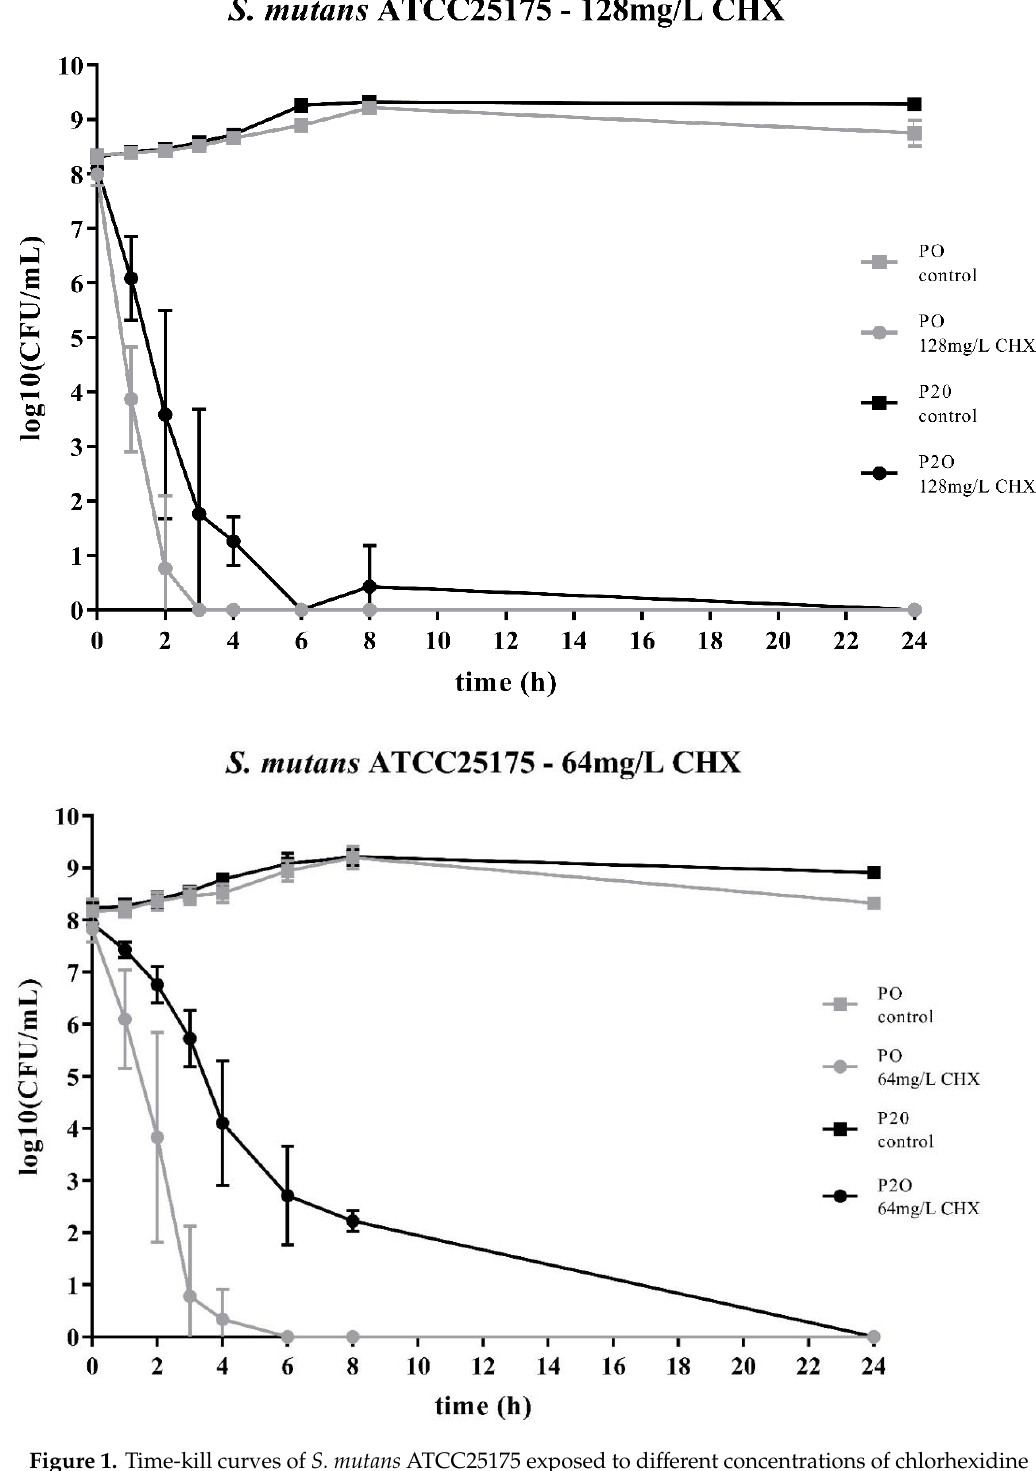
Figure 1. Time-kill curves of S. mutans ATCC25175 exposed to different concentrations of chlorhexidine (CHX). “P0” indicates the bacterial isolate that had not been passaged before on CHX, while “P20” denotes the isolate that have been subcultivated for 20 passages in subinhibitory concentrations of CHX, respectively. The streptococcal isolates were exposed to either 64mg/L or 128mg/L CHX. The values, shown as log10(CFU/mL), are means of three independent replicates. Error bars indicate the respective standard deviation. As control, untreated cultures without CHX were tested.